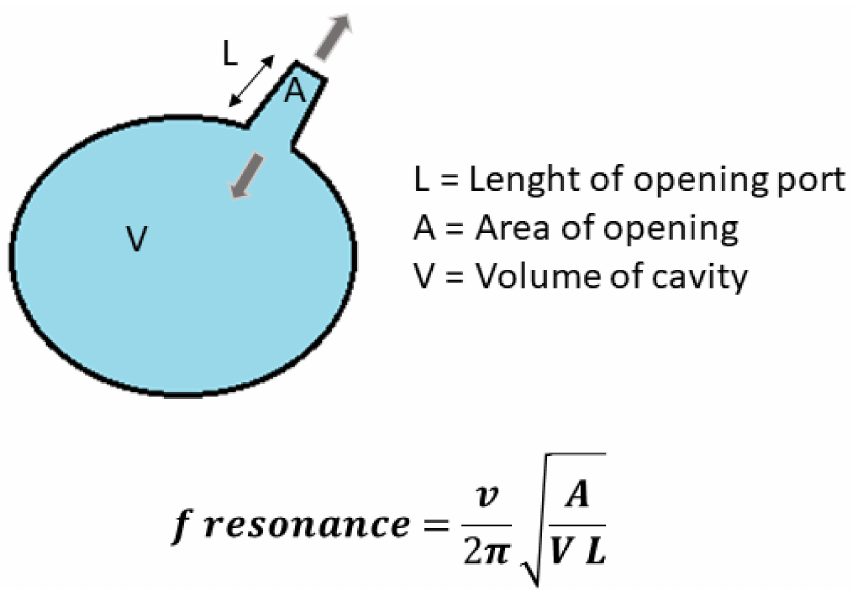
Figure 1. Helmholtz resonator formula. Where v is the Sound Speed in Air, and A , L and V Respec- tively the Section and the Length of the Tube, and the Volume of the